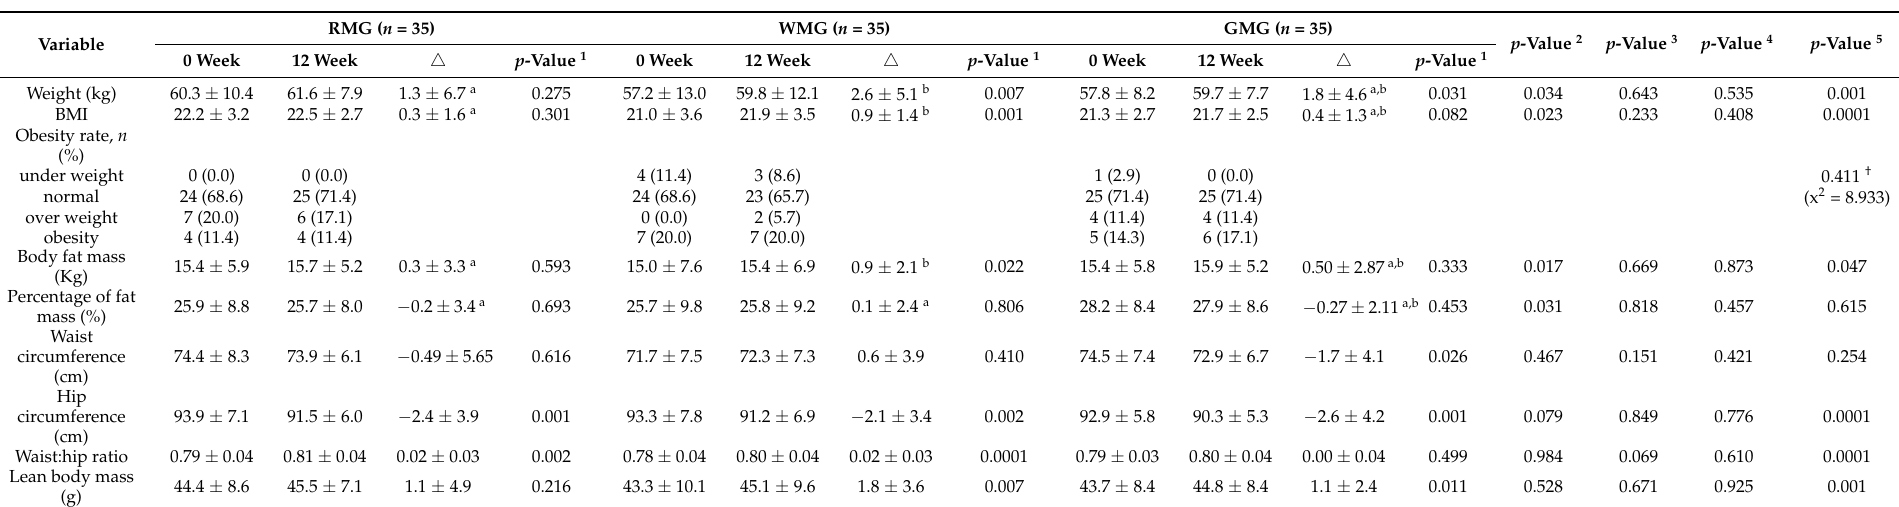
Table 3. Anthropometric measurements of the